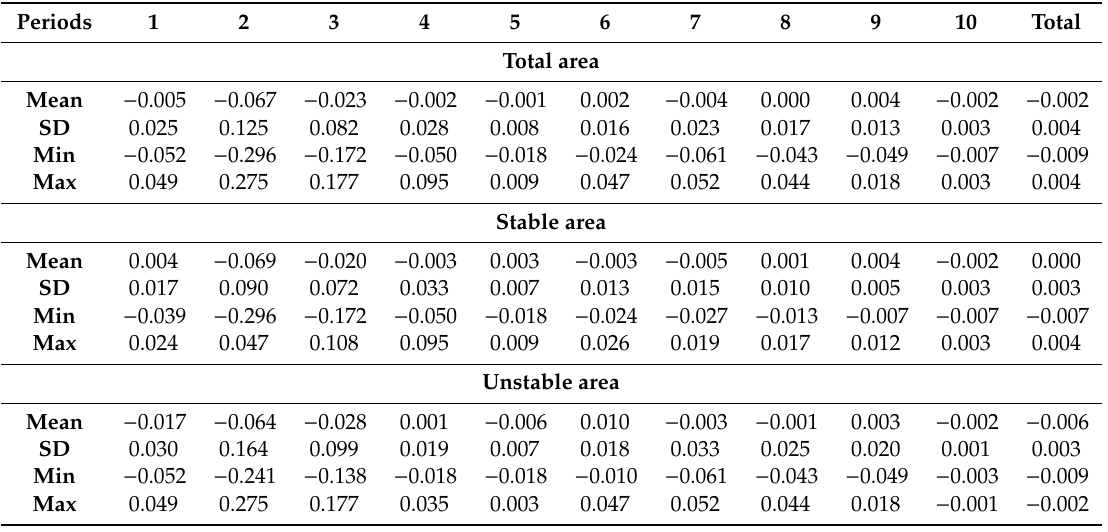
Table 7. Vertical displacement rates (in m / month) of monitoring points in the di ff erent